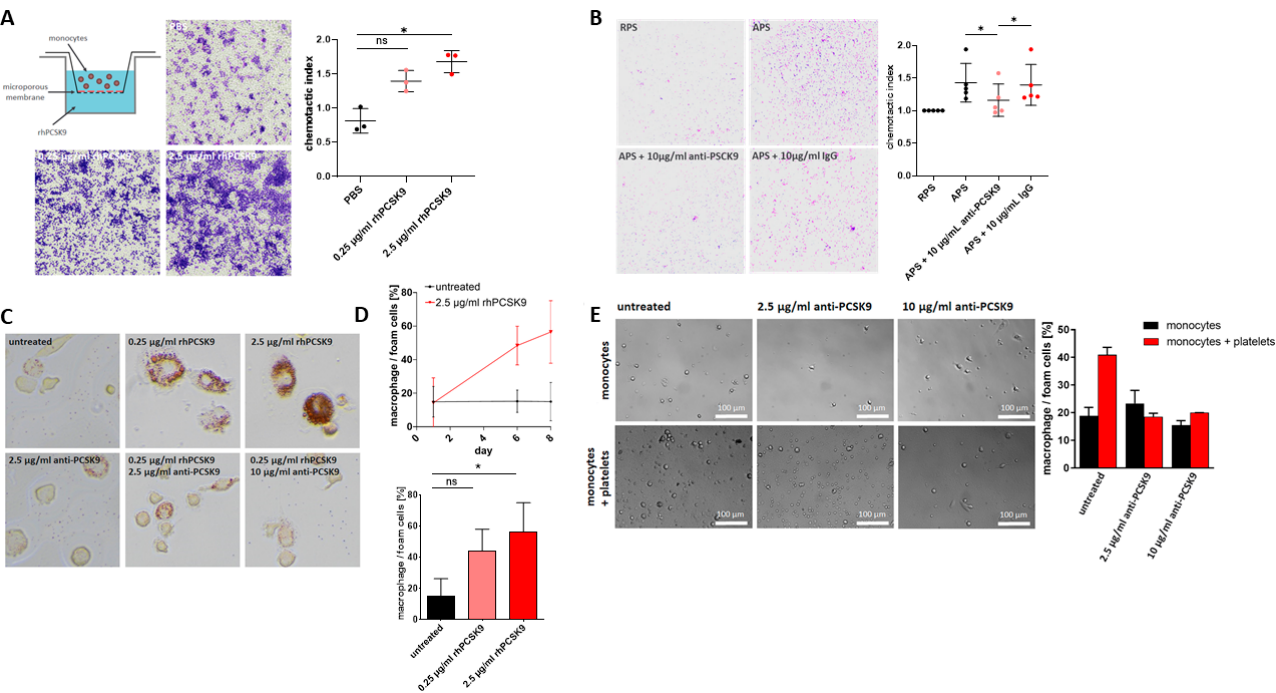
Figure 3. PCSK9 induced platelet migration. ( A ) Schematic view of experimental set up and representative images for three independent experiments. A significant chemotactic effect of rhPCSK9 (0.25 µg/mL and 2.5 µg/mL) on platelets could be observed (plotted: mean ± SEM; n = 3, Kruskal–Wallis test, * p < 0.05). ( B ) Representative images of the chemotactic effect of APS compared to resting platelet supernatants (RPS). This effect is prevented by anti-PCSK9 (10 µg/mL) but not by IgG control (plotted: mean ± SEM; n = 5, Mann–Whitney test, * p < 0.05). ( C ) Platelets propagate monocyte-derived macrophage development via PCSK9. Representative images of macrophage development under stimulation with rhPCSK9 (0.25 µg/mL, 2.5 µg/mL). The effect was inhibited by anti-PCSK9 antibodies (2.5 µg/mL, 10 µg/mL). ( D ) Macrophage/foam cells development over eight days under rhPCSK treatment (2.5 µg/mL). Statistical analysis of macrophage/foam cells development after eight days treatment with rhPCSK9 (0.25 µg/mL, 2.5 µg/mL) showed significant increase in macrophage/foam cells development (plotted: mean ± SEM; n ≥ 3, biological replicates; Kruskal–Wallis test, * p < 0.05). ( E ) Representative images of monocytes and monocytes/platelet co-culture. The analysis of macrophage development in monocyte/platelet co-culture after nine days treatment with anti-PCSK9 antibodies (2.5 µg/mL, 10 µg/mL) showed inhibition of macrophage development (plotted: mean ± SEM, n = 2).